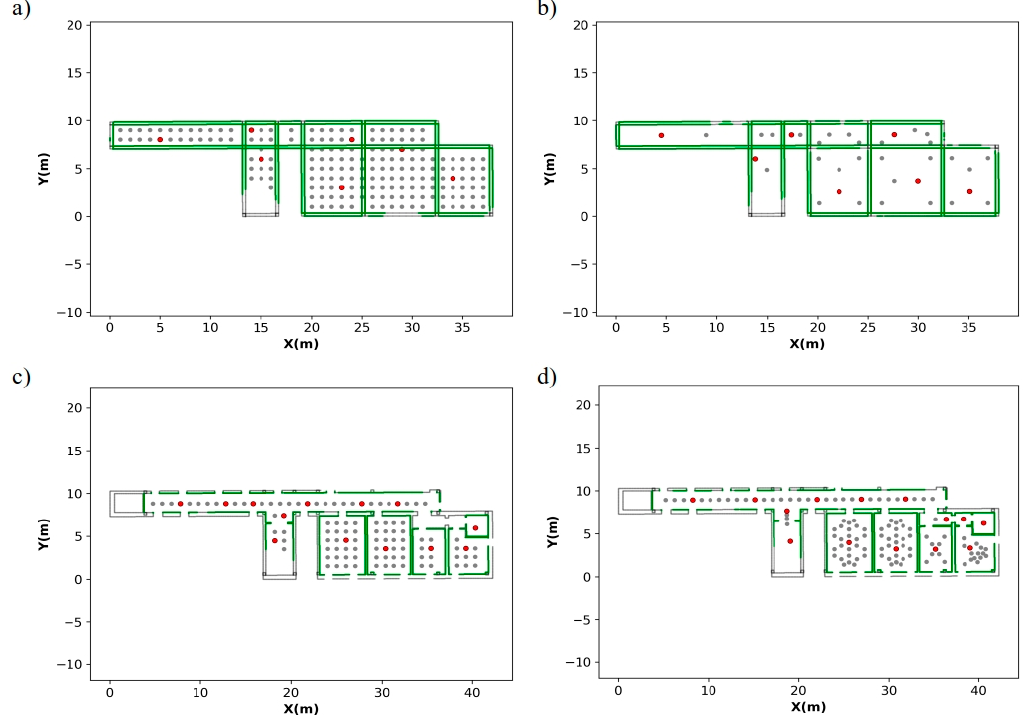
Figure 20. Optimization scan position result in case study 2.